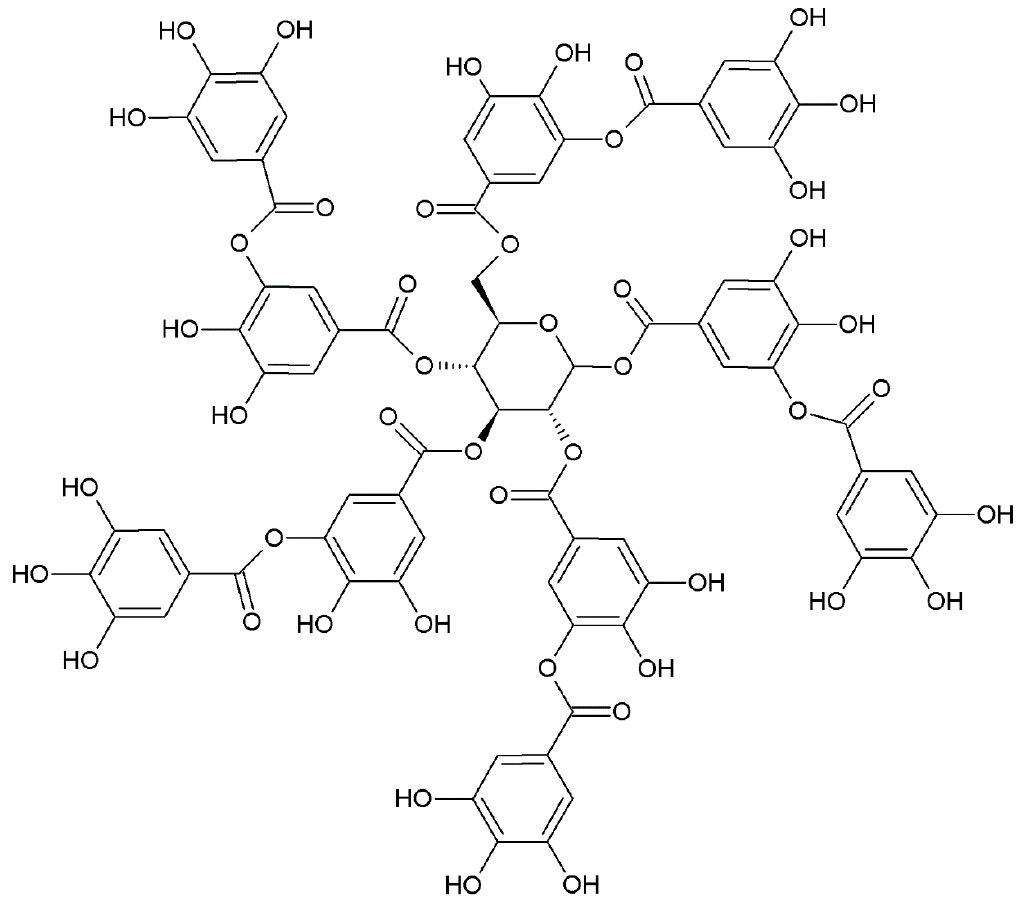
Figure 2. Chemical structure of tannic acid.